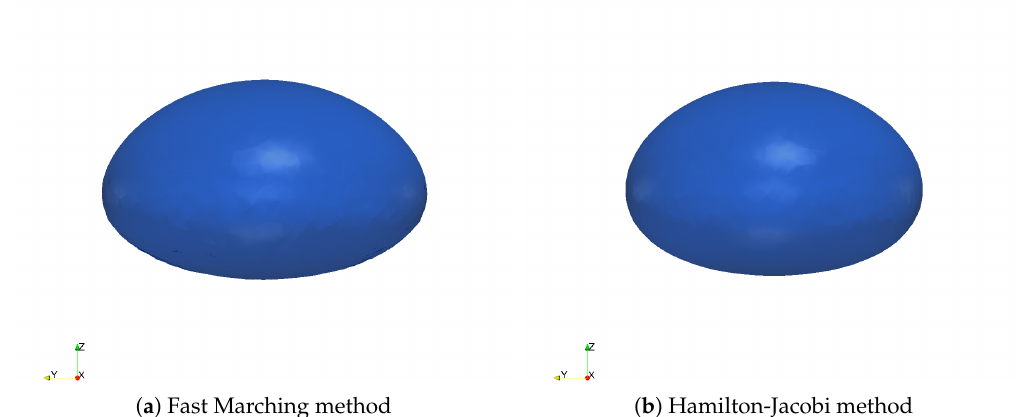
Figure 4. 3D shape at final time ( t = 3) in the x - y plane for test case 1 ( h = 0.0175).